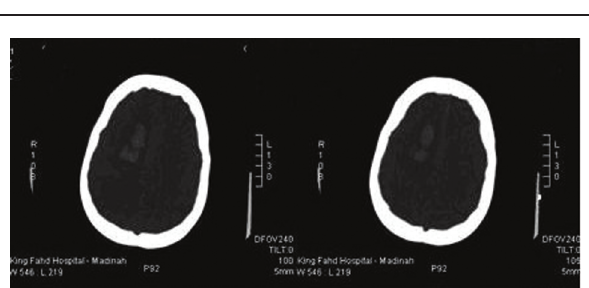
CT brain showed cerebral heamorrage.